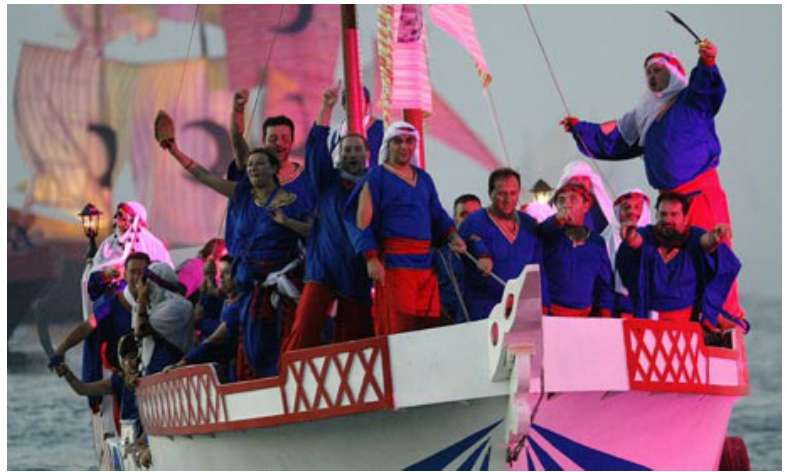
Courtesy of Wikimedia Commons